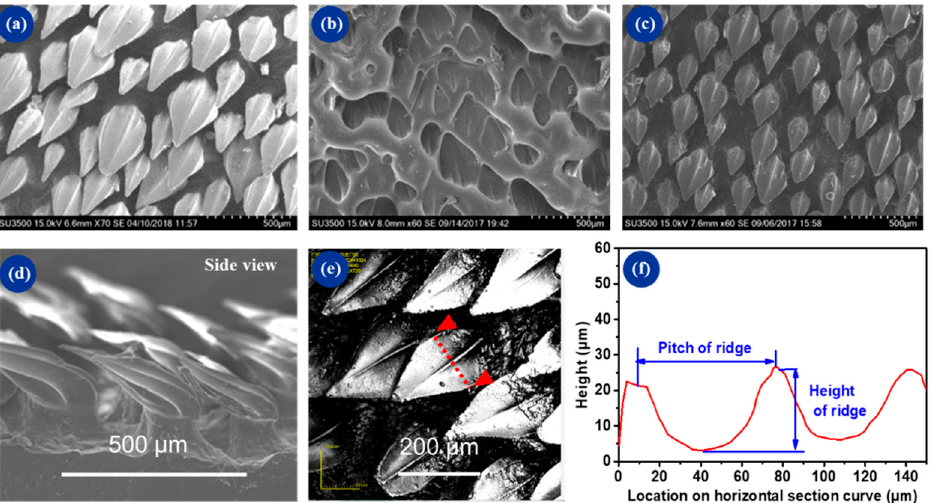
Figure 4. SEM and surface profile of shark skin, negative mold, and replicated polyurethane (PU) coating: ( a ) pretreated shark skin, ( b ) negative mold, ( c ) replicated shark surface, ( d ) side view of dermal denticles, ( e ) confocal microscope image, and ( f ) the section profile of dermal denticles that was marked in ( e